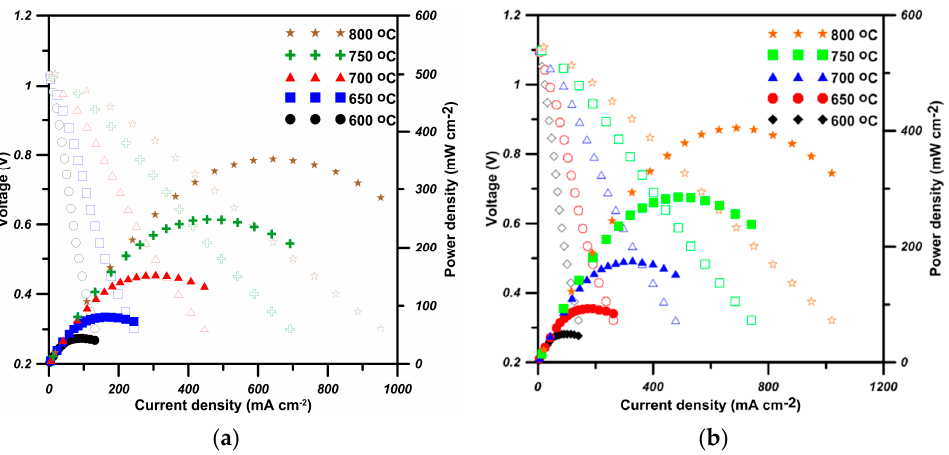
Figure 8. Output voltage and power density of the cells: ( a ) with the LSFC; and ( b ) with S50C20 cathode as a function of current density.